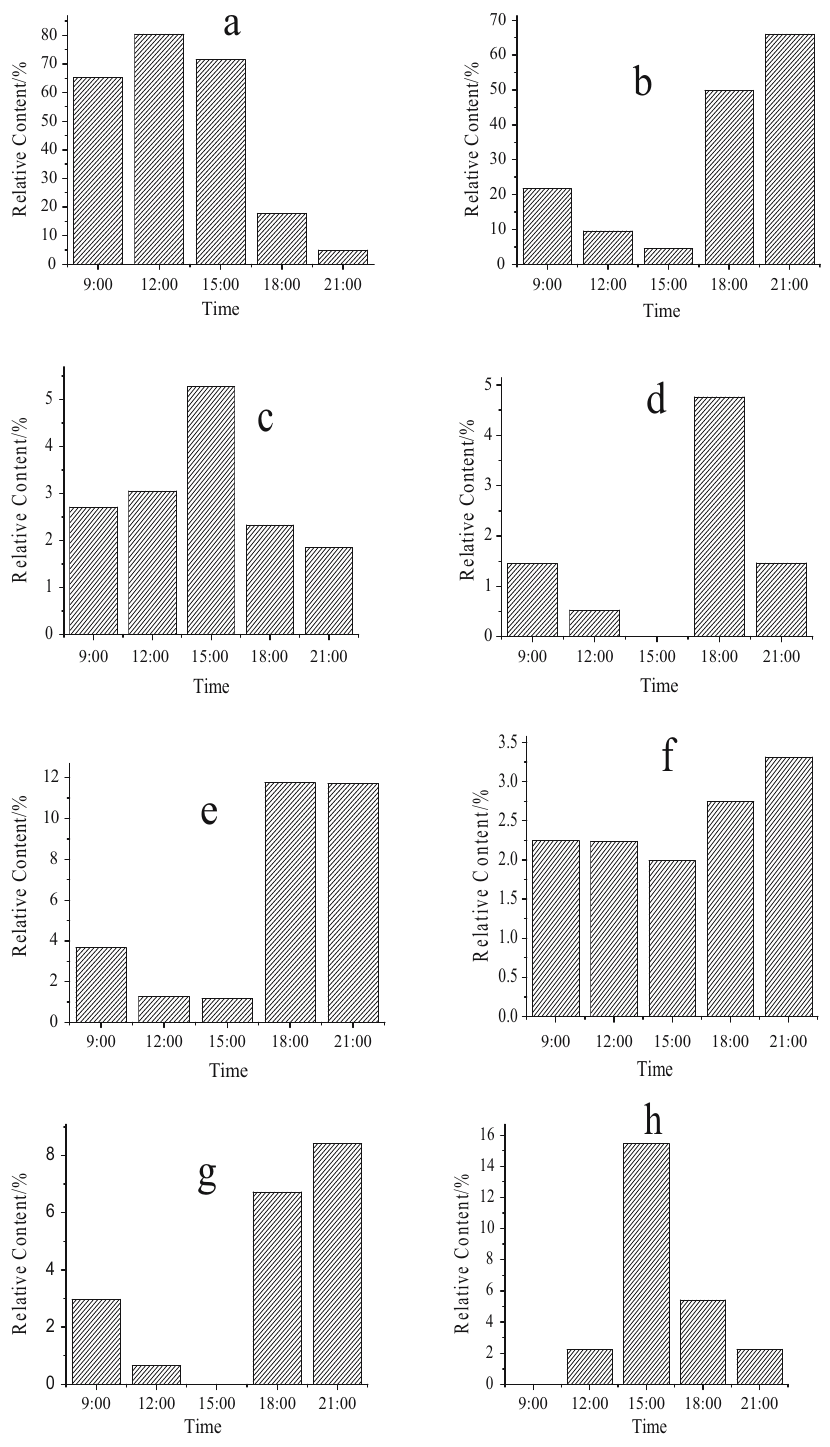
Figure 2: The diurnal variation of total release amount of fl oral scent from rose (( a ) alcohol, ( b ) fatty hydrocarbon, ( c ) terpenes, ( d ) aldehydes, ( e ) ketones, ( f ) esters, ( g ) arenes, ( h ) others )